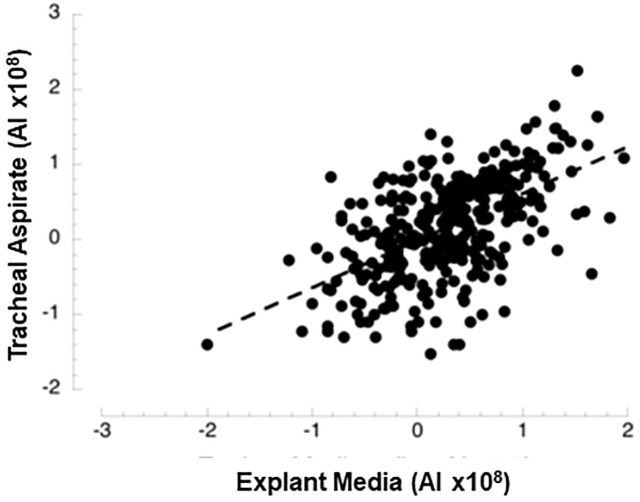
Comparison of abundance levels for proteins of TA and culture medium of human fetal lung explants.By linear regression analysis of log transformed data there is a highly significant positive correlation (r = 0.56, p<10−30).